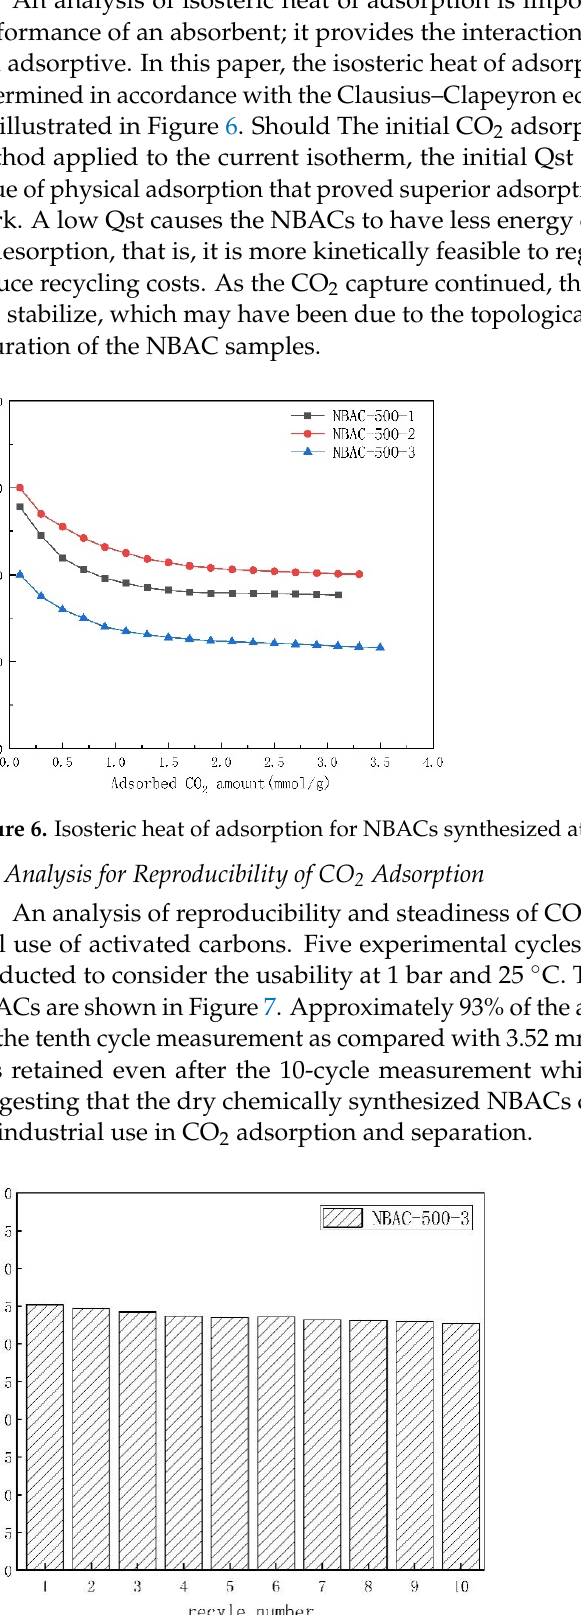
Figure 5. Adsorption selectivity of CO 2 over N 2 for NBAC synthesized at 500 °C.